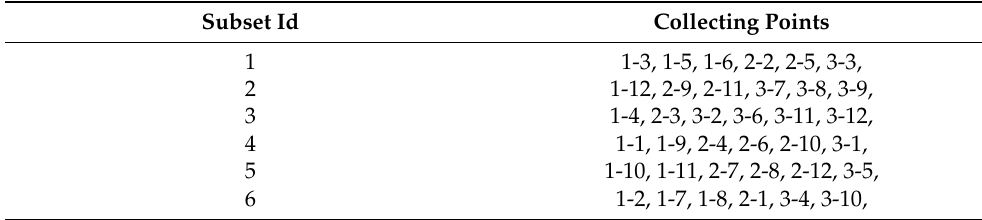
Table 2. Dataset subset split for 6-fold